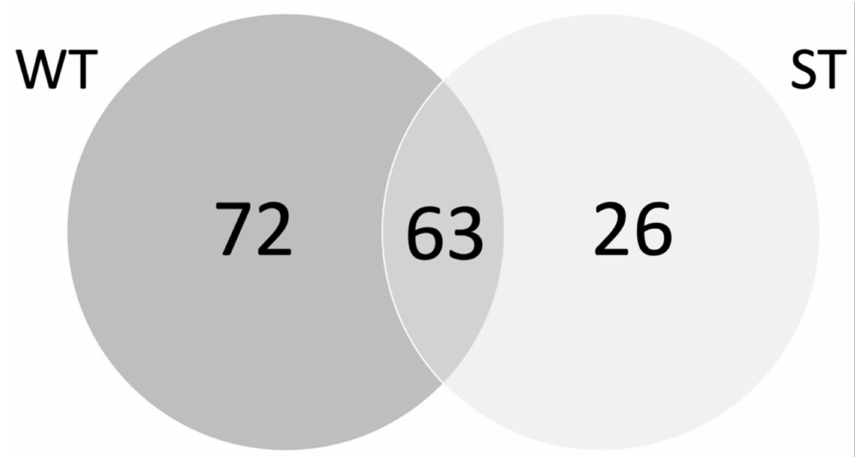
Figure 5. Venn diagram showing the distribution of sheep abomasal whole tissue (WT) and abomasal scrape tissue (ST) that specifically bound to Teladorsagia circumcincta galectin